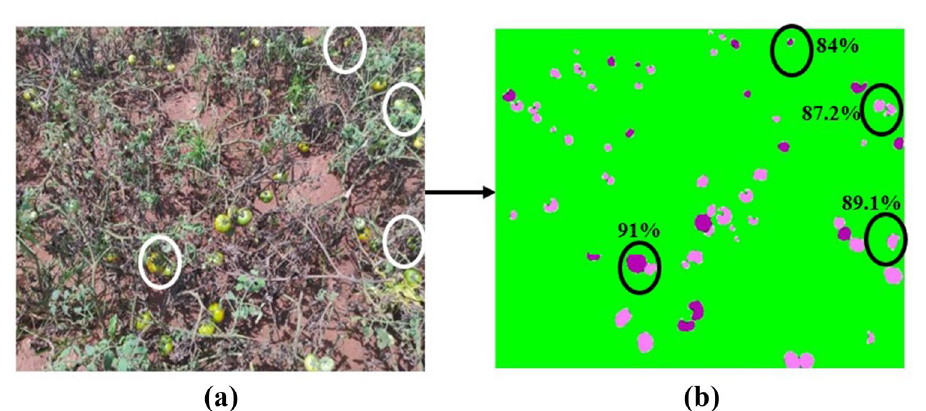
Figure 7. Prediction for occlusion ( a ) original test image, ( b ) predicted test image with precision (in